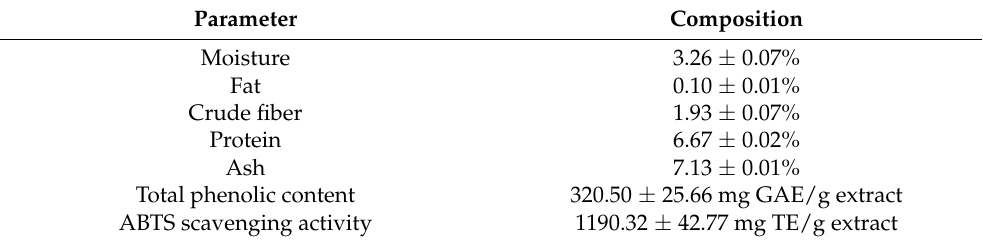
Table 1. Chemical composition and antioxidant activity of MSE (wet basis).